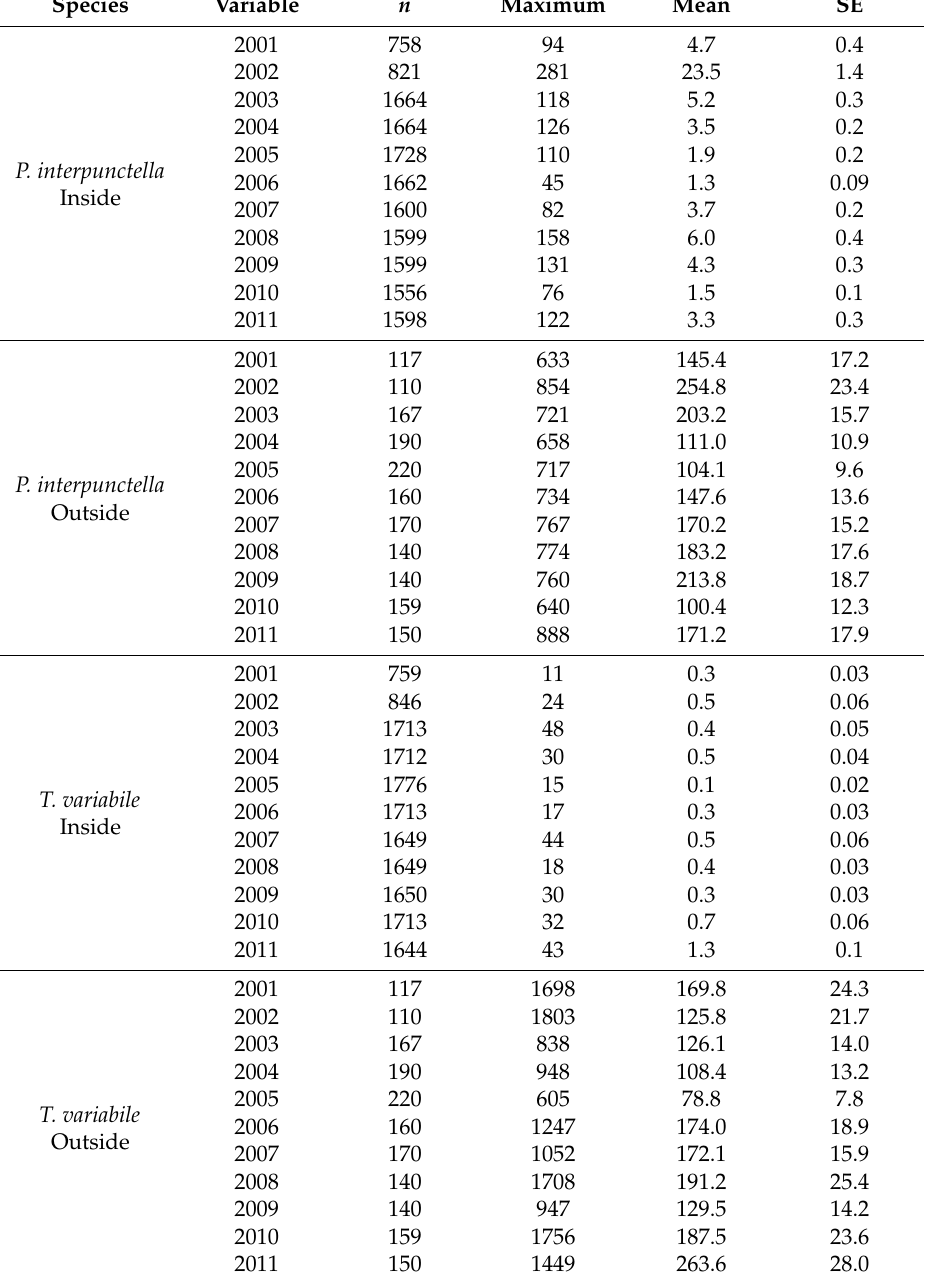
Table 3. Means and maximum counts per year, inside and outside. Minimum counts in all cases is 0. SE = standard